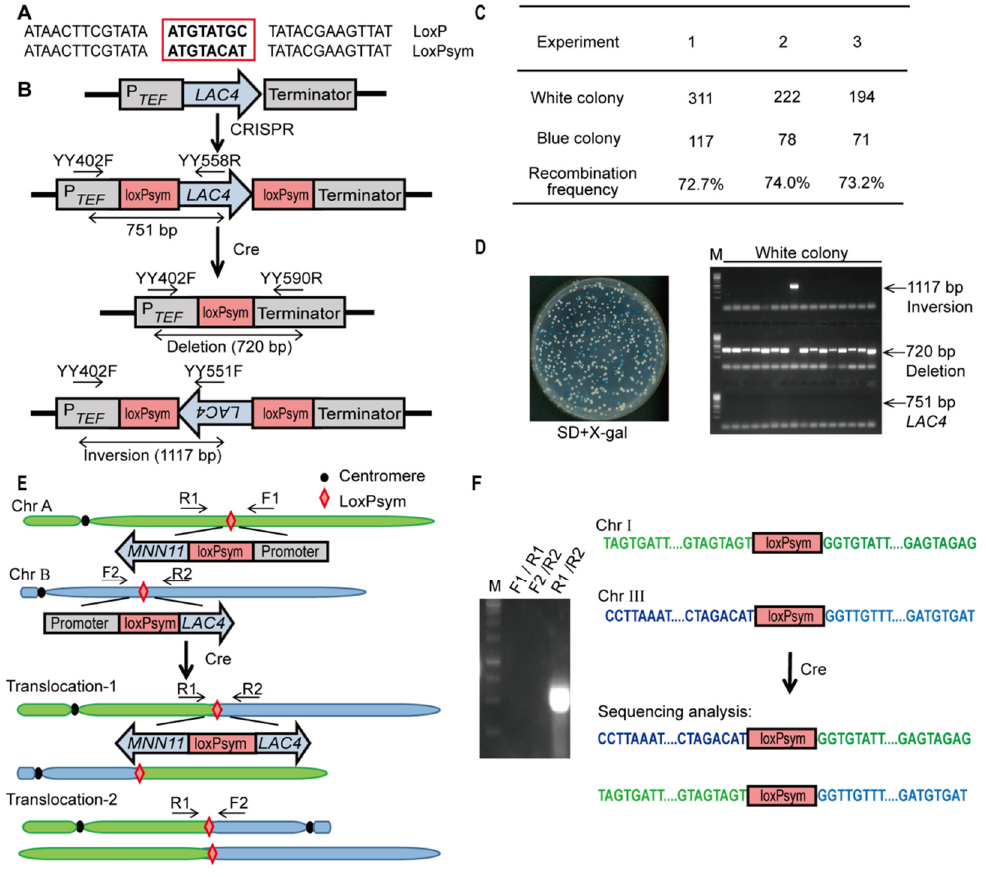
Figure 3. Recombination between loxPsym sites. ( A ) Sequences of loxP and loxPsym sites. The 8-bp central spacer regions are shown in the red box. ( B ) A schematic representation of recombination between loxPsym sites flanking LAC4 ORF. ( C ) The recombination efficiency between loxPsym sites. The efficiency was indicated by the percentage of white colonies on SD + X-gal plates. ( D ) Identifica- tion of type of recombination by PCR. Intact LAC4 locus produced a band of 751 bp. Inversion and deletion of LAC4 ORF produced bands of 1117 bp and 720 bp, respectively. ( E ) A schematic repre- sentation of interchromosomal rearrangements mediated by the recombination between loxPsym sites. ( F ) Identification of rearrangements by PCR. A band produced by primer R1 and R2 indicated interchromosomal rearrangements. Fused sequences from Chr I and III through loxPsym sites are shown on the